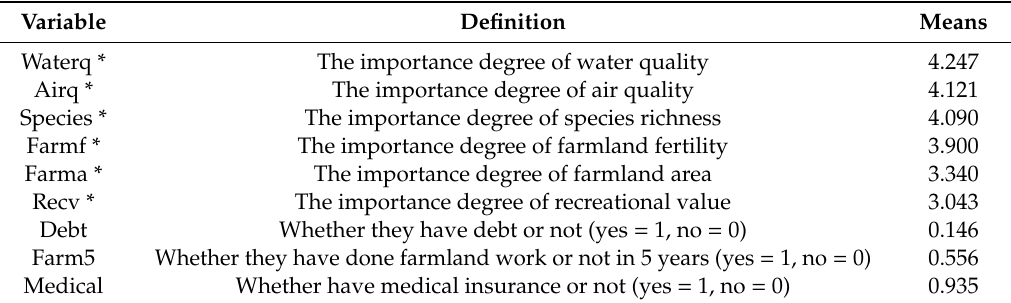
Table 3. Definition of variables and their importance